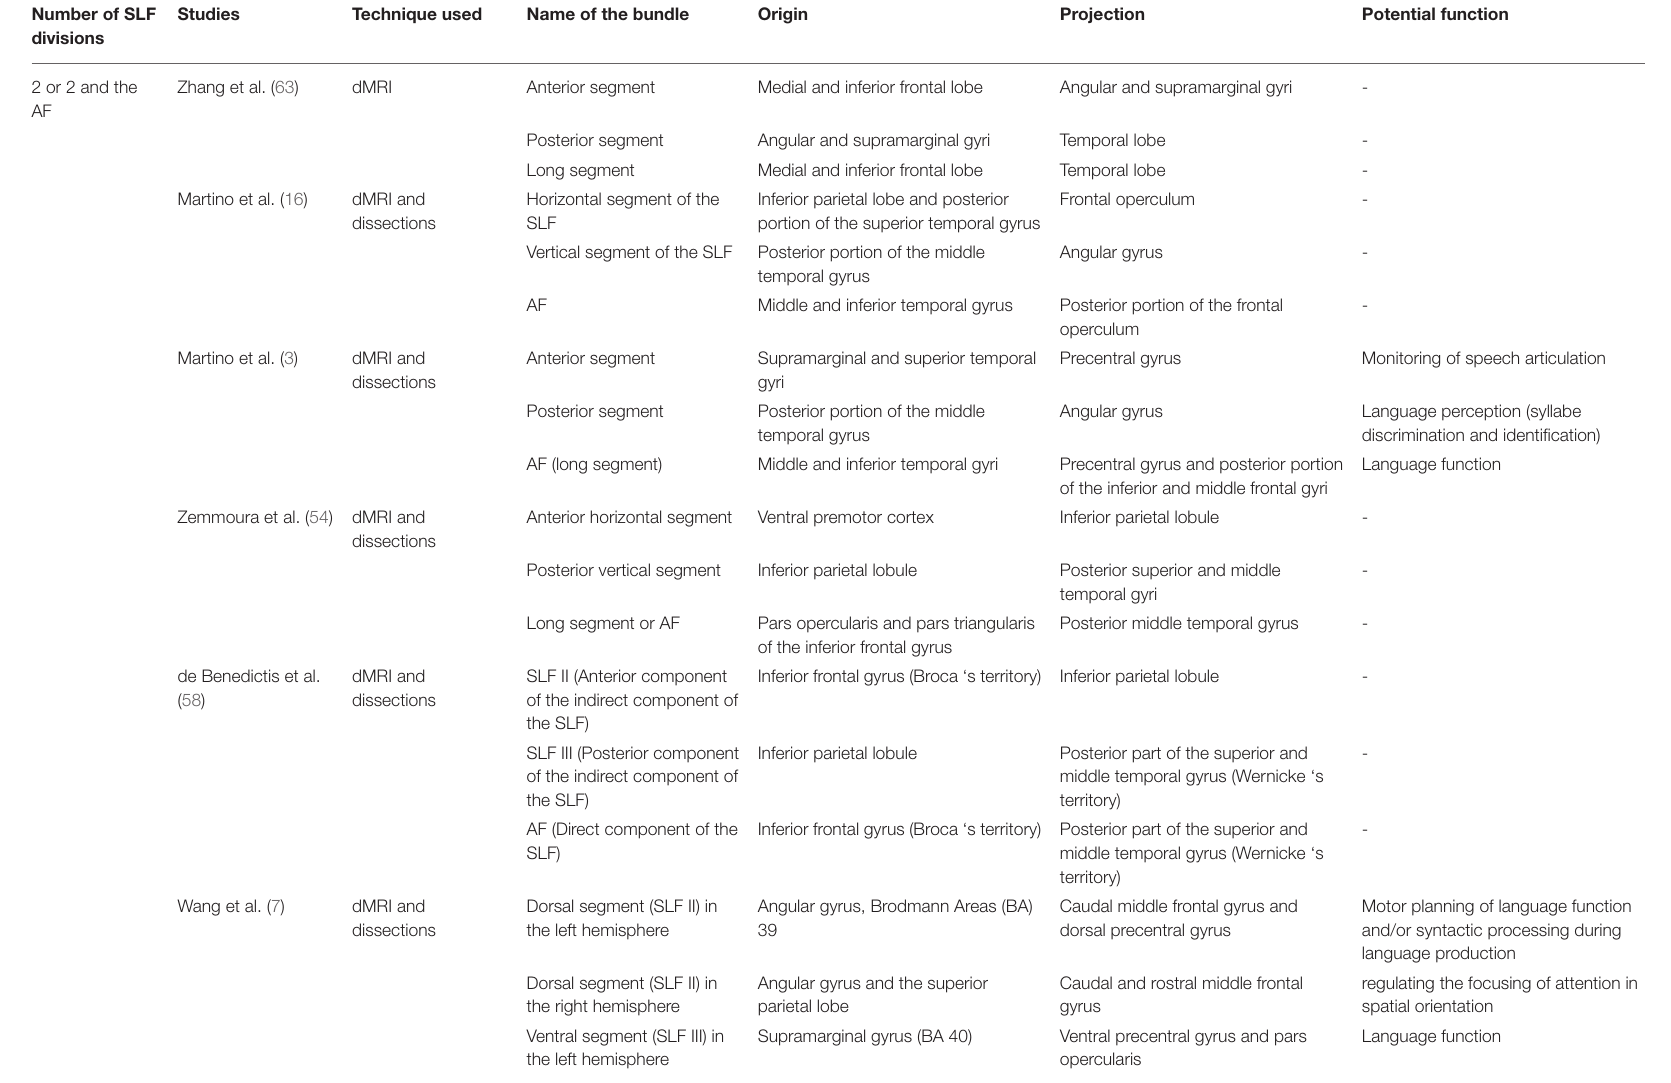
TABLE 1 | A summary of dissection and imaging studies relative to the characteristics of the SLF